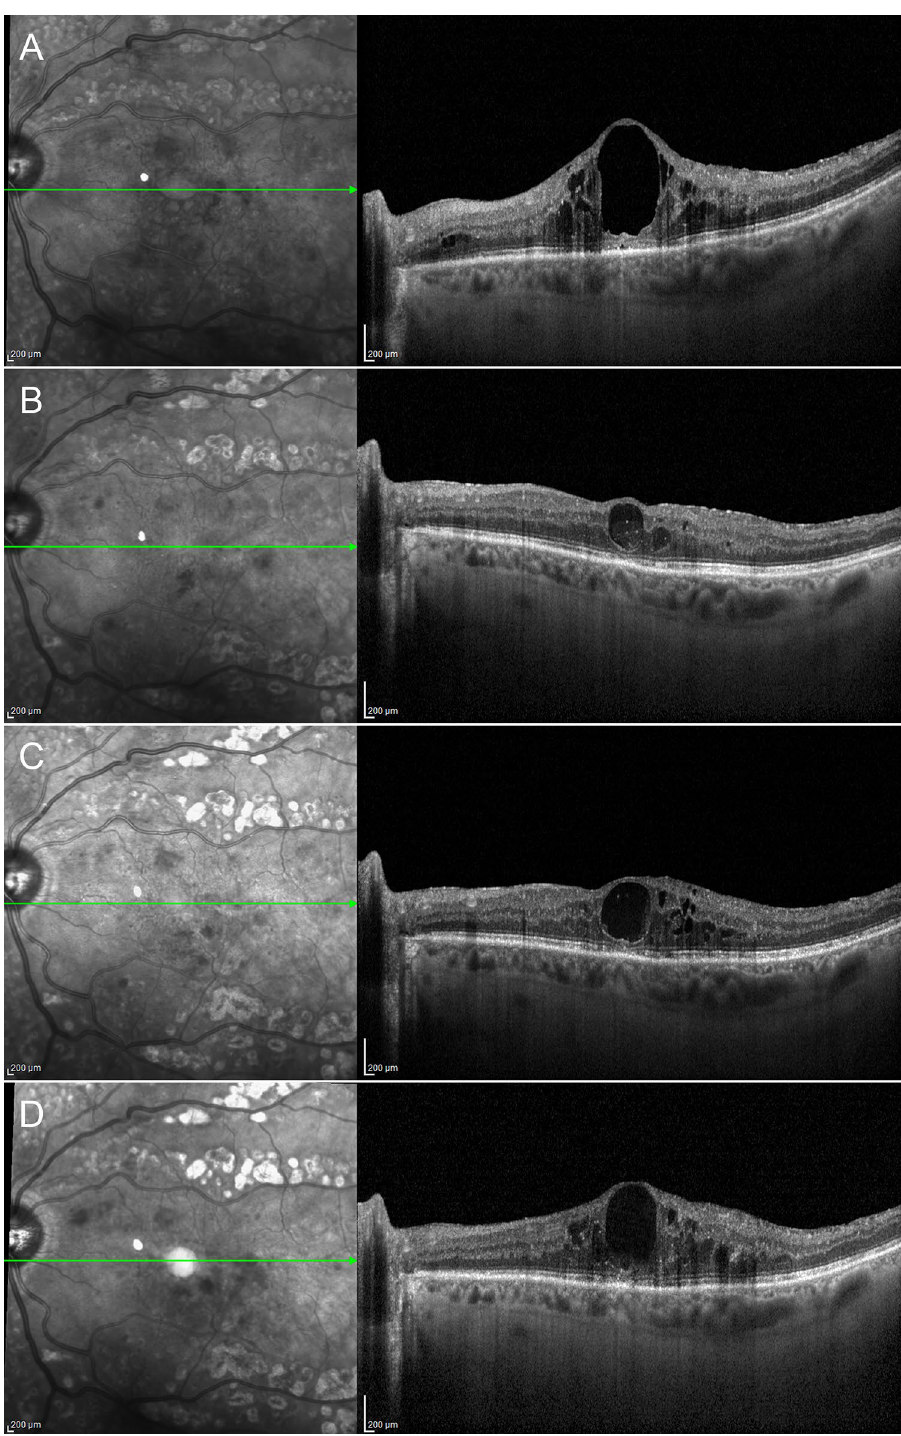
Figure 4. Foveal eversion Pattern 2. Baseline image shows foveal eversion with no signs of vertical transretinal foveal material ( A ). Although responsive to treatment, this DME shows persistent clinical behavior ( B , C ) over the follow-up (6-month and 9-month F/U, respectively). The last examination shows a disrupted ellipsoid zone at the level of the fovea ( D